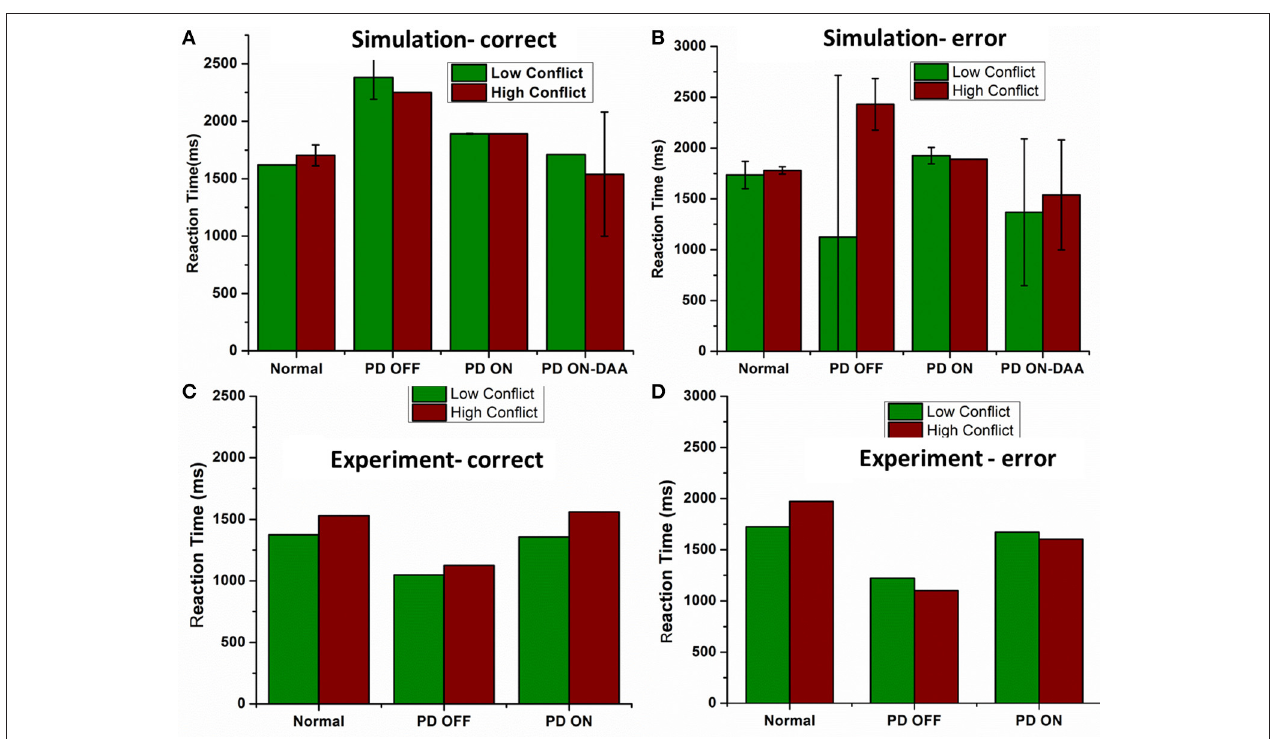
FIGURE 9 | Shows the reaction time in milliseconds (ms) for various conditions applied on the spiking BG model (A) Reaction time (ms) obtained from the model for all the four conditions Normals, PD OFF, PD ON (L-DOPA, DAA) for LC and HC condition in correct trials. (B) Reaction time (ms) measured from the model for all the four conditions [Normals, PD OFF, PD ON (L-DOPA, DAA)] for LC and HC condition in error trials. Experimental Reaction time (ms) obtained from Normal, PD OFF and PD ON condition for (C) correct and (D) error trials from Frank et al.